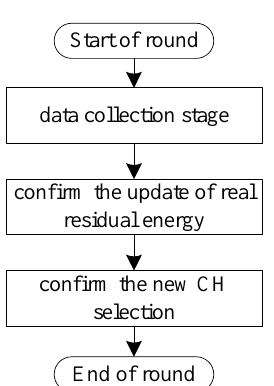
Figure 4. The flowchart for the working process of sensor nodes (including the CH and CMs) in one